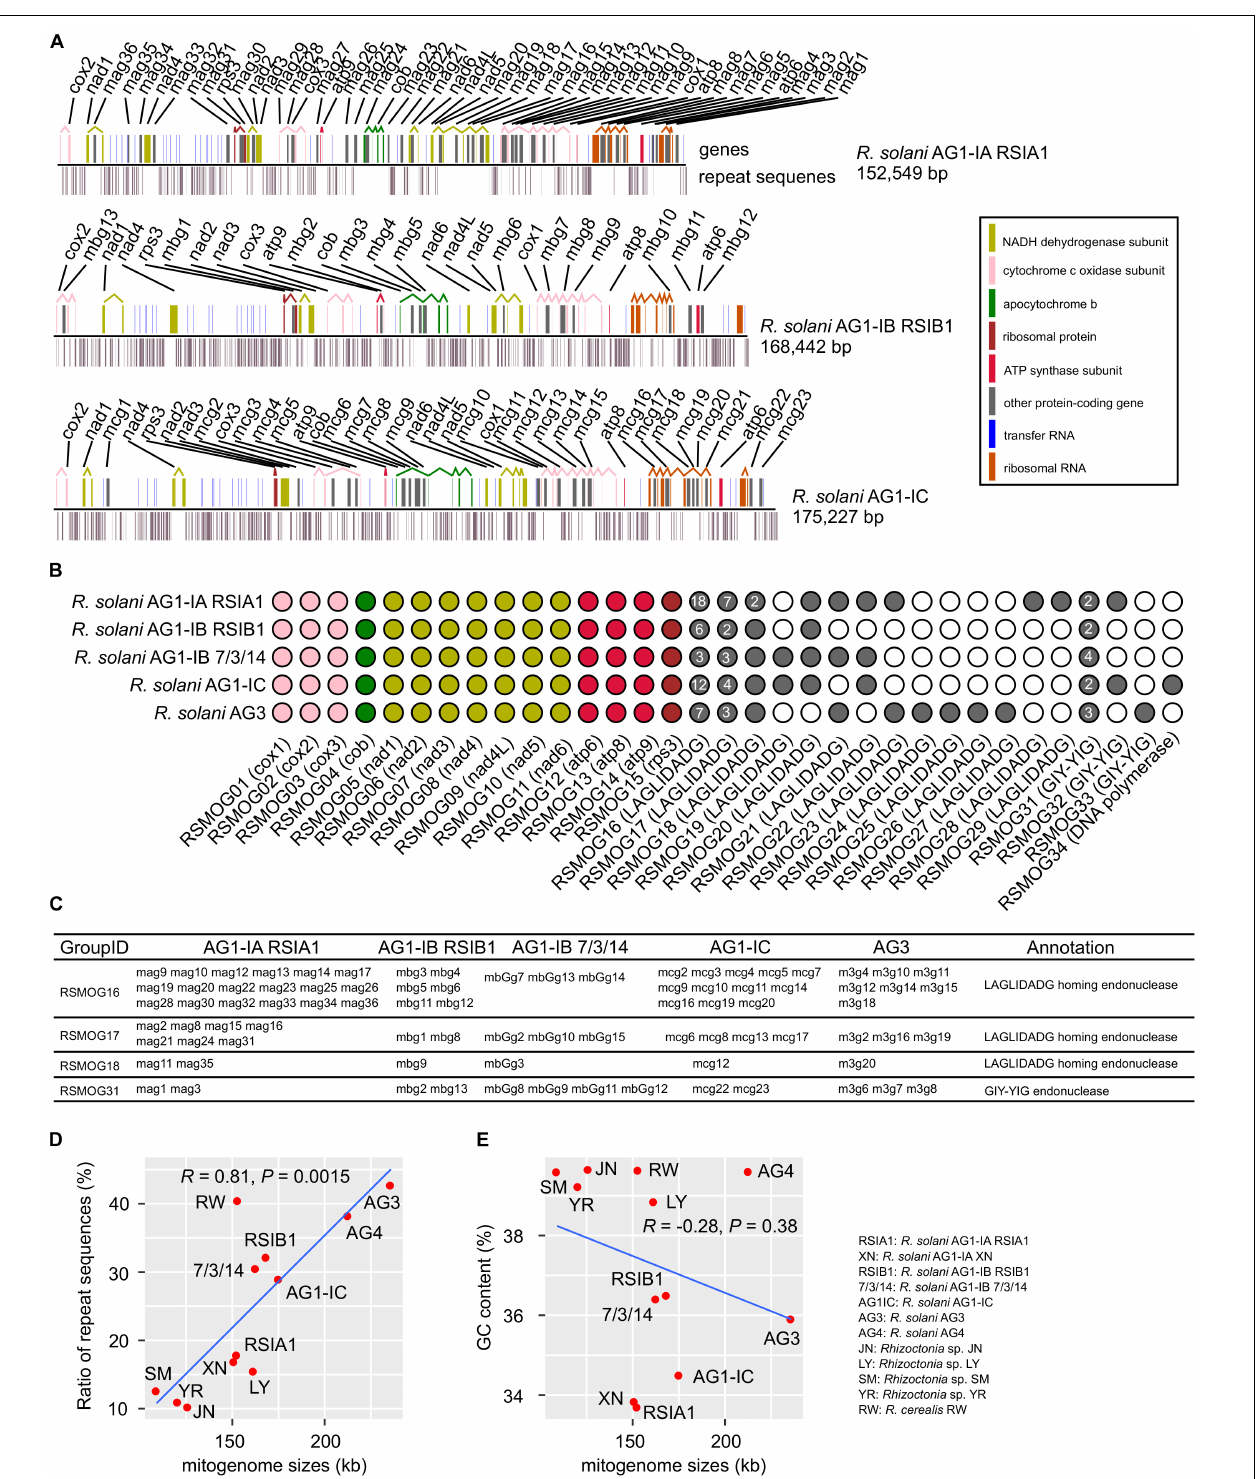
FIGURE 1 | Characterization of mitogenomes in Rhizoctonia solani . (A) Maps of six mitogenomes. The genomic positions of genes and repeat sequences were shown. Many protein-coding genes contained multiple exons that were connected by broken lines. (B) Orthologous groups of protein-coding genes in mitogenomes. (C) Four groups contained multiple genes. (D,E) Distribution of repeat sequences and GC contents in Rhizoctonia mitogenomes. In the MATERIALS AND METHODS section (Mitogenome assembly and annotation), we described selecting Rhizoctonia mitogenomes for comparative analysis. The R functions (ggplot and stat_cor with the Pearson correlation coefficient method implemented in ggplot2 and ggpubr packages, respectively) were used to draw the (D,E) .